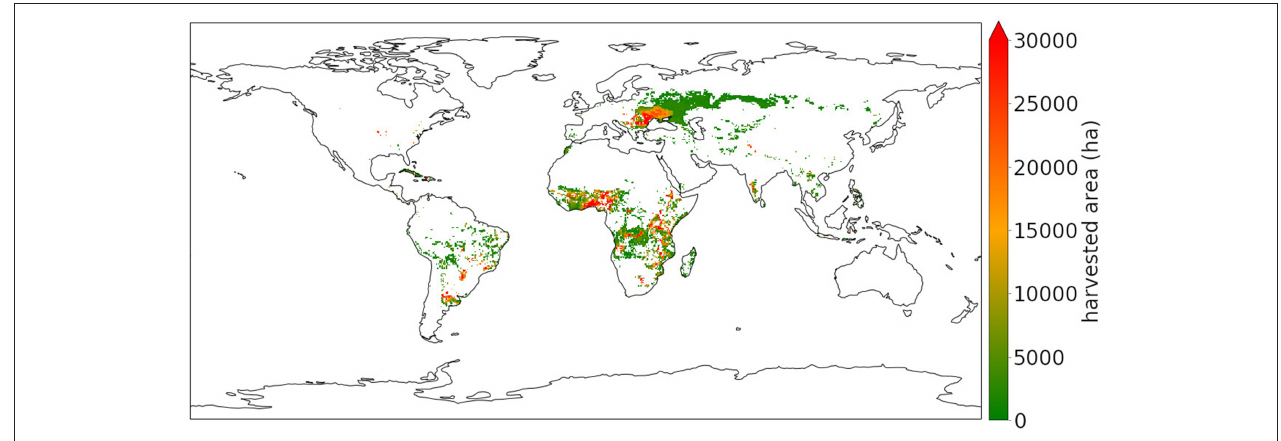
FIGURE 5 | Grid cells in which yield increases come at the lowest cost in additional N losses. Those grid cells for which yield increases would reduce the global average yield-scaled N losses of both N 2 O and NO − 3 are colored according to their harvested areas (i.e., grid cells for which 1 N/ 1 Y for N 2 O emissions is less than the global average value of 0.44 kg-N/Mg and for NO − 3 leaching is < 6.2